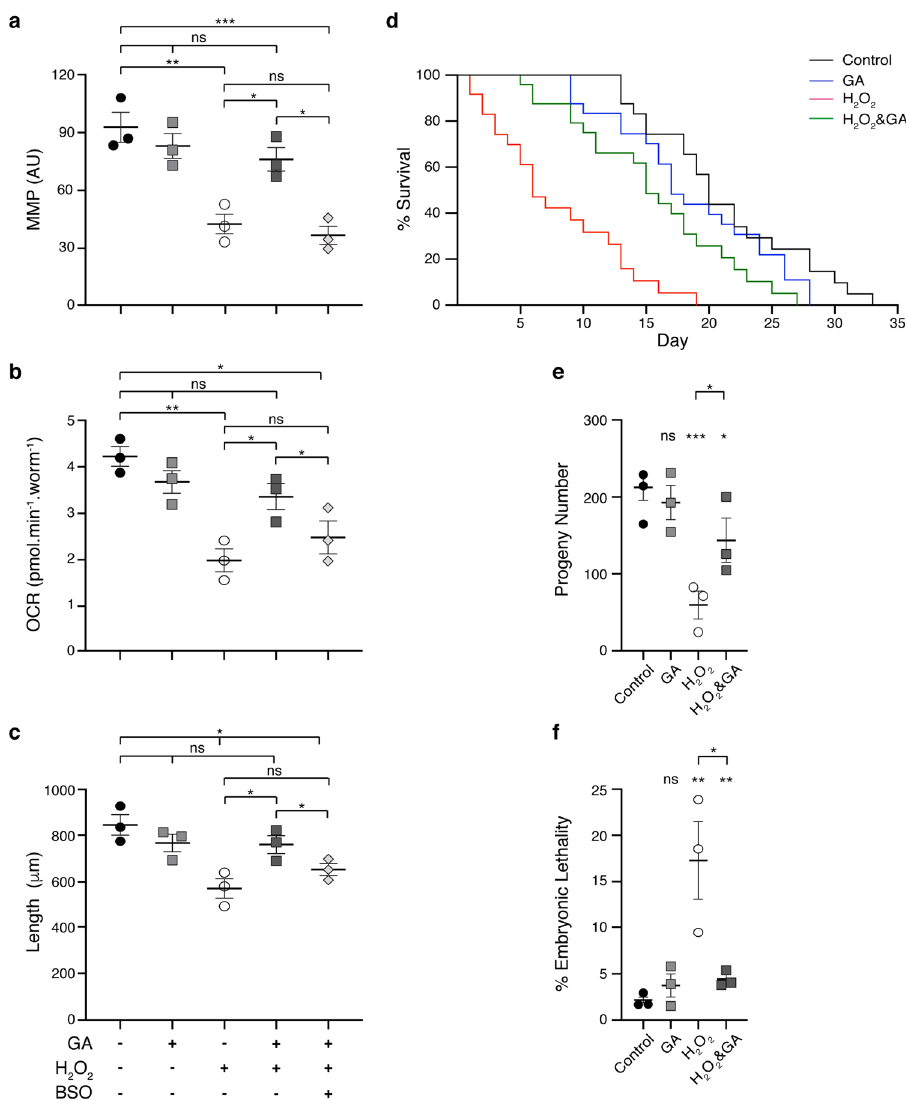
Fig. 2 Glycolate supplementation maintains mitochondrial function and improves animal physiology of peroxide-treated C. elegans worms. a Mitochondrial membrane potential ( ΔΨ m-MMP) was measured in the different strains after 3 days of treatment via MitoTracker Red CMXROS staining and recording the fl uorescence intensities. b Respiration rates in terms of oxygen consumption rate (OCR) determined after 4 days of treatment using a Seahorse Analyzer and normalized to number of worms. c Size of worms after 4 days of treatment, where the lengths in μ m of at least 20 animals were averaged per condition in each experiment. In d – f , life span analysis without FUdR, brood size, and embryonic lethality, respectively, is shown for worms that had been exposed to H 2 O 2 and 10 mM GA, as indicated, during larval development. Error bars represent standard error of the mean ( n =